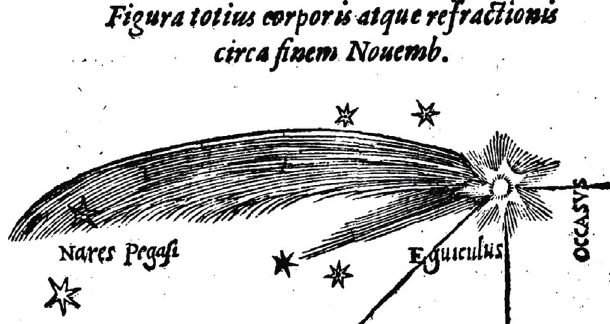
Fig. 3. Gemma ’ s diagram of the comet C/1577 V1, captioned as “ The shape of the entire body and refraction [of the comet] ca. in the end of November ” , adapted from Gemma (1578, p.